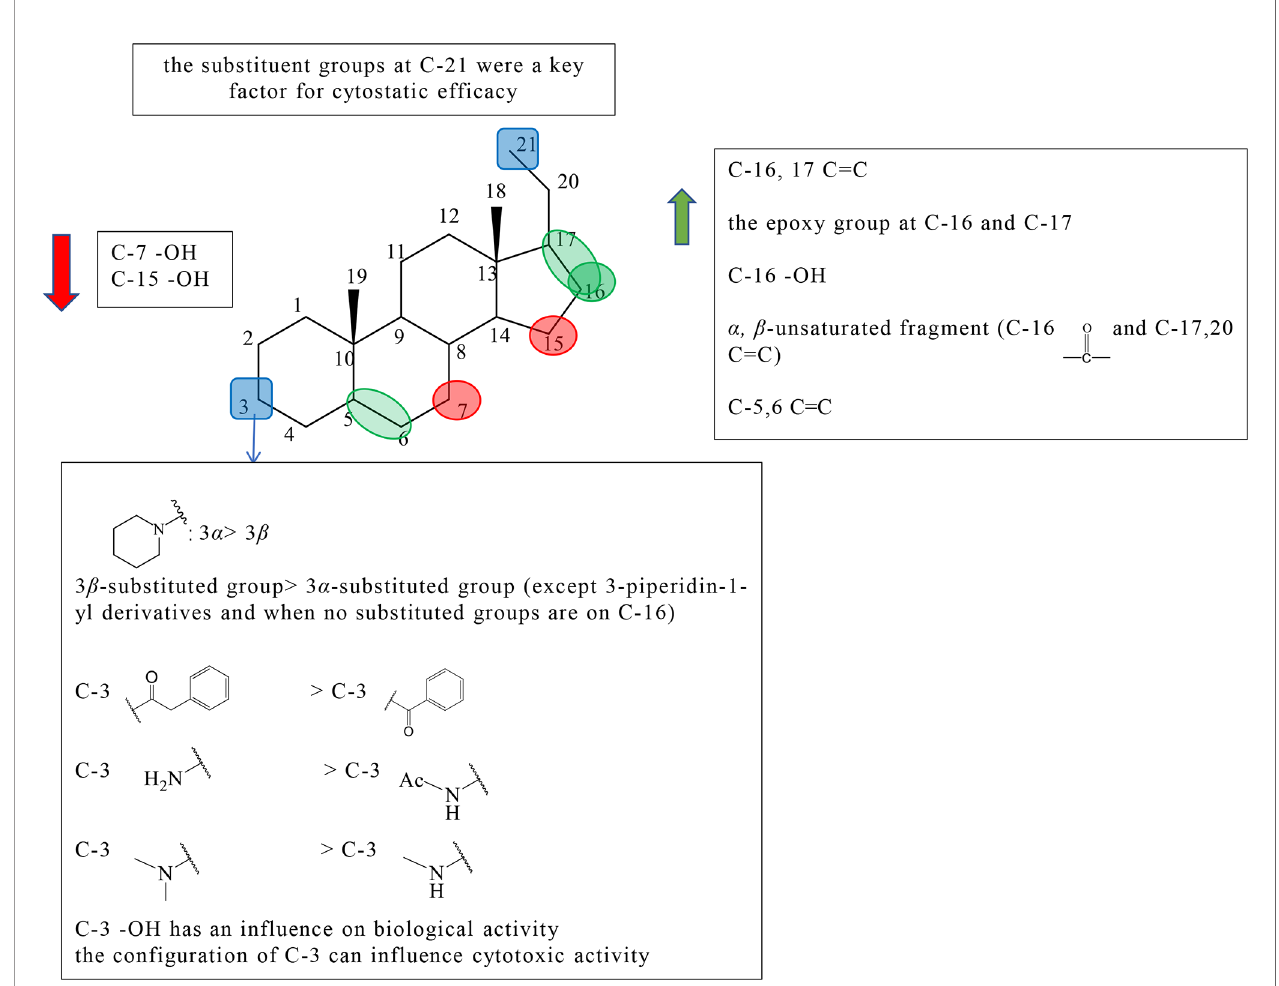
FIGURE 2 | Summary of Structure-activity Relationship of Pregnane